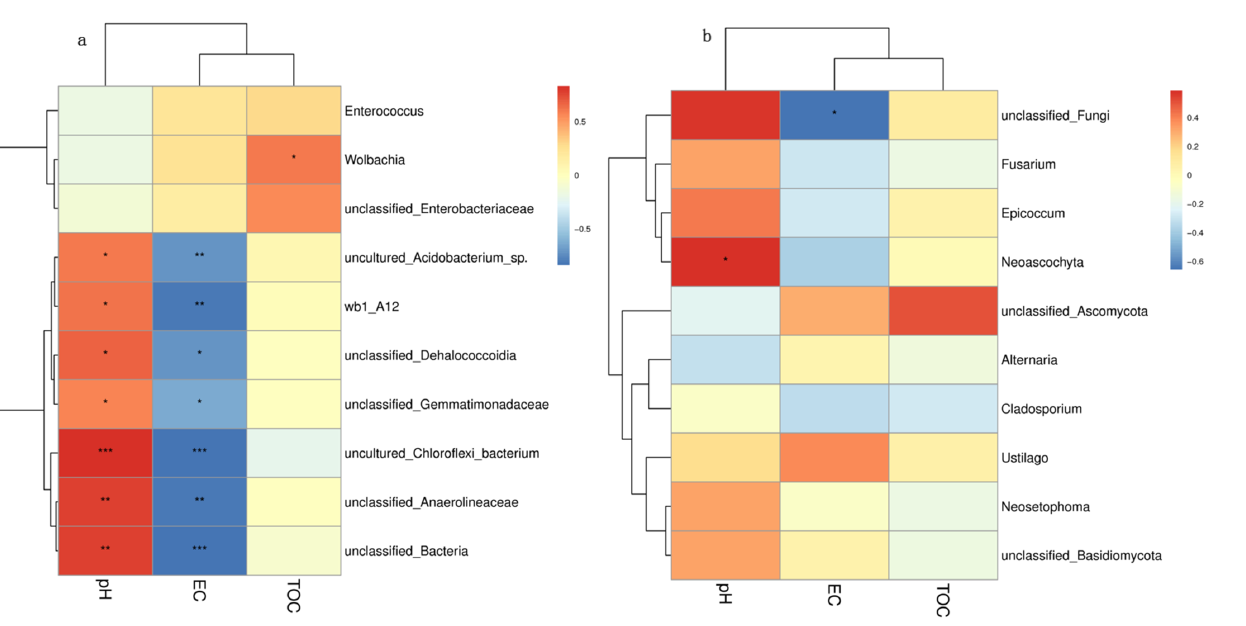
Figure 8. Correlation between soil bacterial species and soil physicochemical properties. The rela- tionship between the soil physicochemical properties and bacterial ( a ) and fungal ( b ) genera. The color changes represent the degree of correlation, which reflects the degree of adaptation of species groups to the rhizosphere and non-rhizosphere soil. Different colors mean different correlation. JSS: the bulk soil sample; XRS: soil of the P. sibiricum rhizosphere. *, ** and *** represent a statistical significance at p ≤ 0.05, p ≤ 0.01, and p ≤ 0.001, respectively.